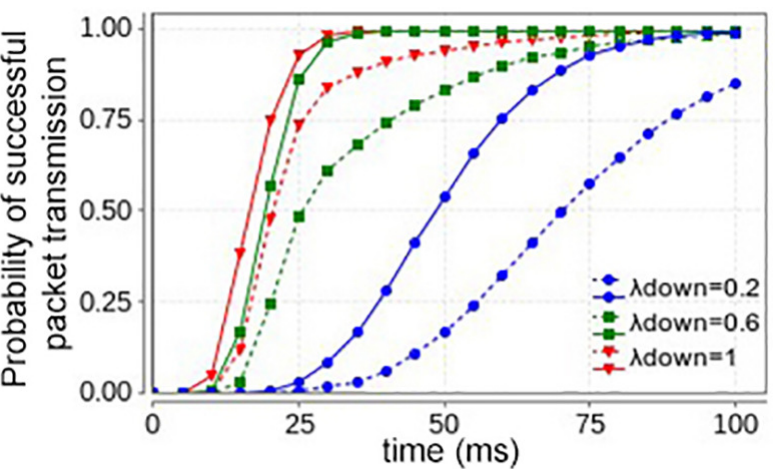
Figure 4. Proof-of-concept-results for downstream and upstream traffic: mechanism proposed in [21] (dotted line), time-out and wake-up mechanisms (solid line).